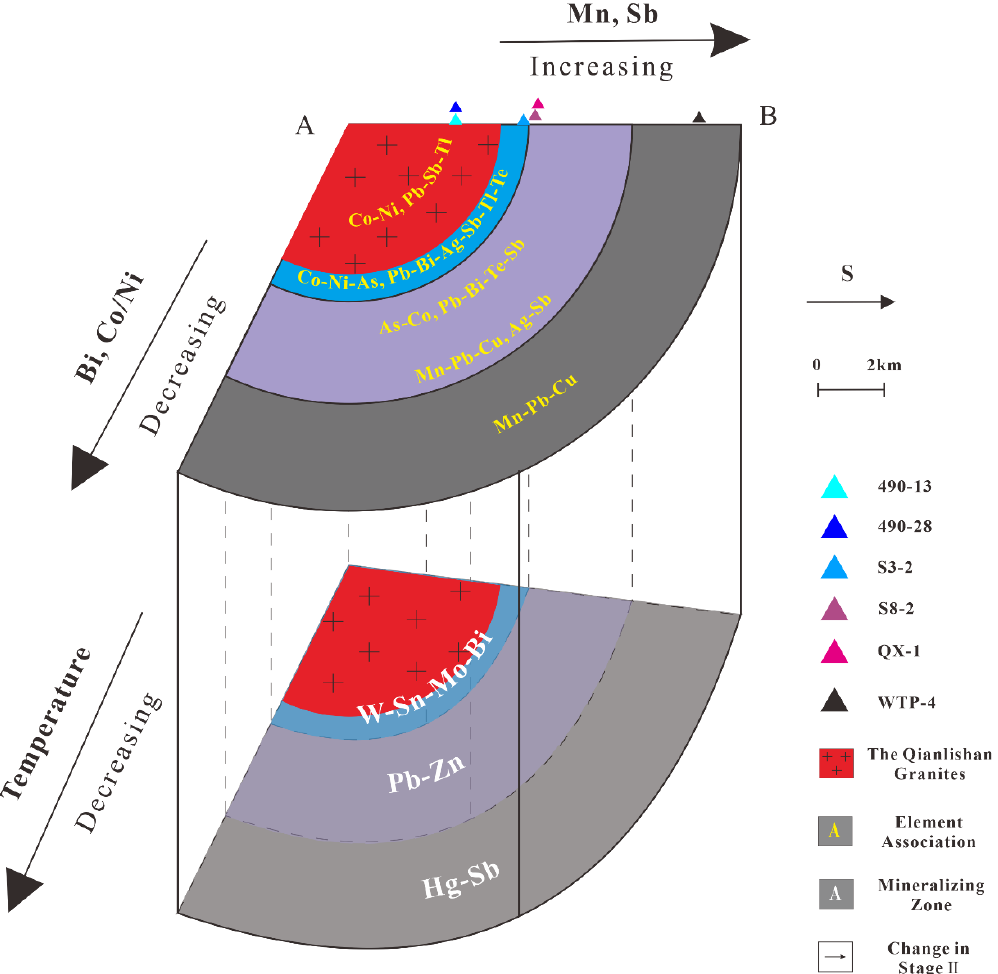
Figure 18. The regular variation from the inner zone to the outer zone in the Shizhuyuan ore-field.